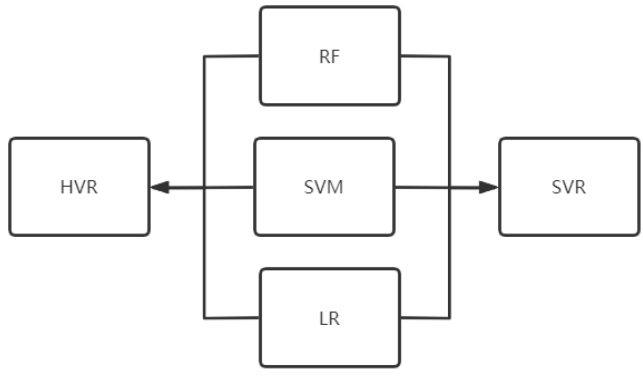
Figure 4. Generating hard voting HVR and soft voting SVR.